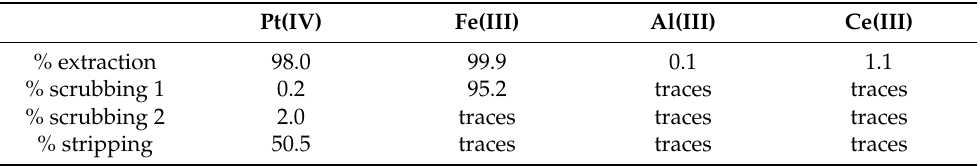
Table 2. Extraction, scrubbing, and stripping percentages achieved for the SX process applied to the model solution 1